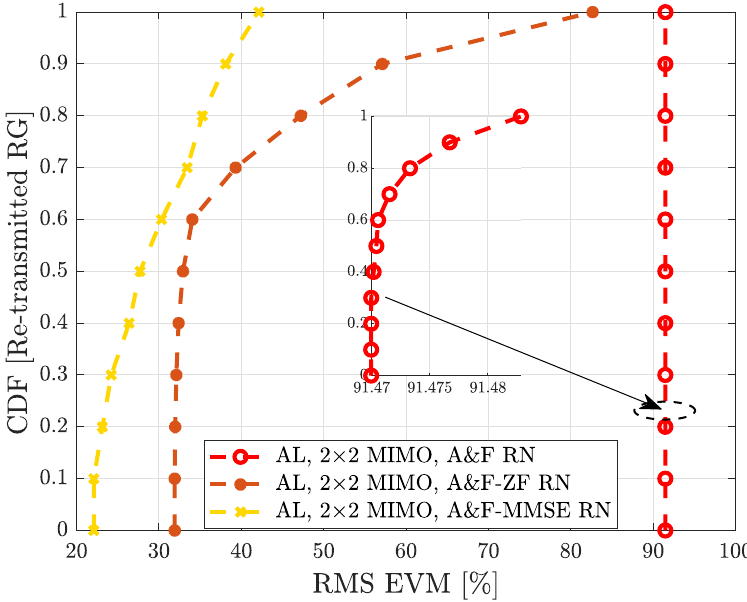
Figure 12. EVM of the Re-transmitted Resource Grid from A&F Relay